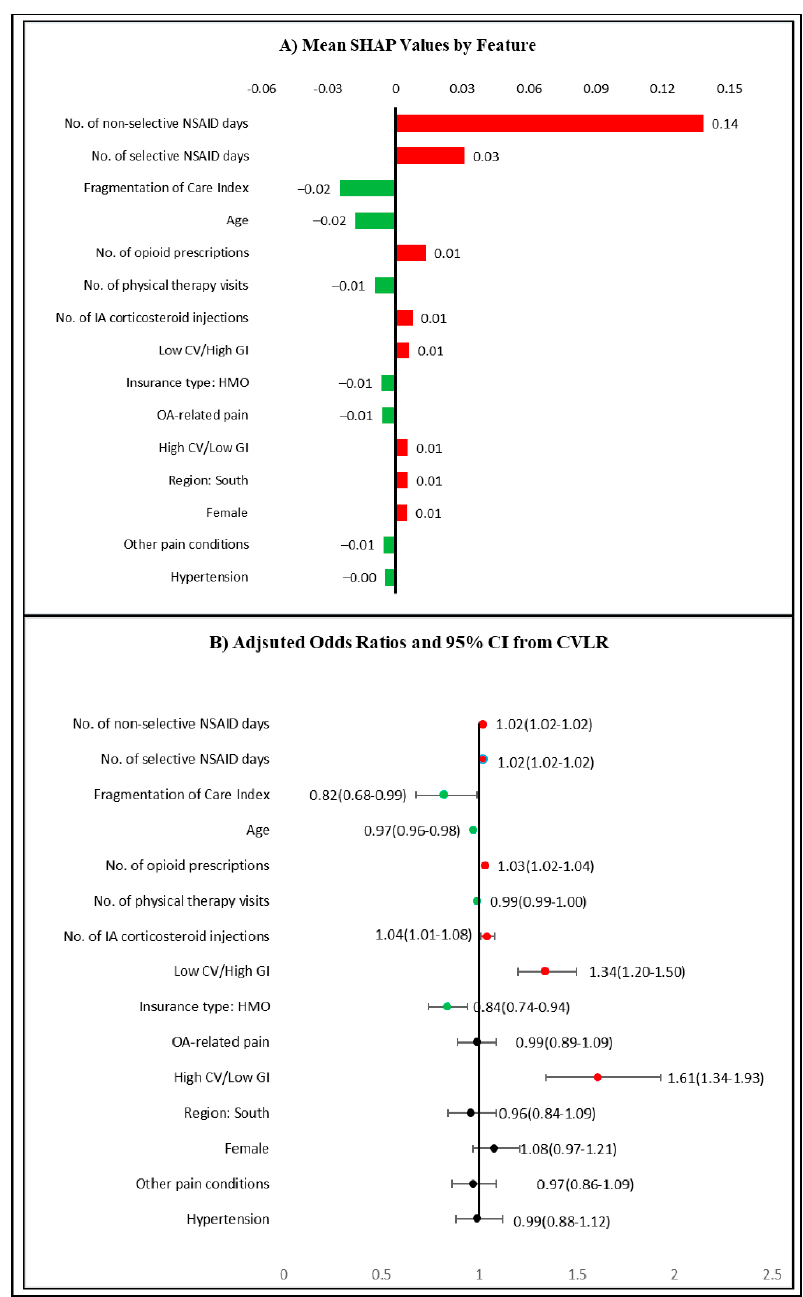
Figure 4. Association of Top Predictors to Potentially inappropriate NSAIDs. ( A ) Mean SHAP values by feature based on XGBoost. The bars show the average impact of a feature on XGBoost model output. ( B ) AOR and 95% CI for top 15 features based on an adjusted CVLR. The CVLR was adjusted for all features described in Section 2.4.2. Red bars/dots indicate an increase in the predicted probability/higher odds of potentially inappropriate NSAIDs use, respectively. Green bars/dots indicate a decrease in the predicted probability/lower odds of potentially inappropriate NSAIDs use, respectively. Based on 44,990 older adults (age > 65) with OA using data from Optum De-identified Clinformatics ® Data Mart who were continuously enrolled in Medicare Advantage plan